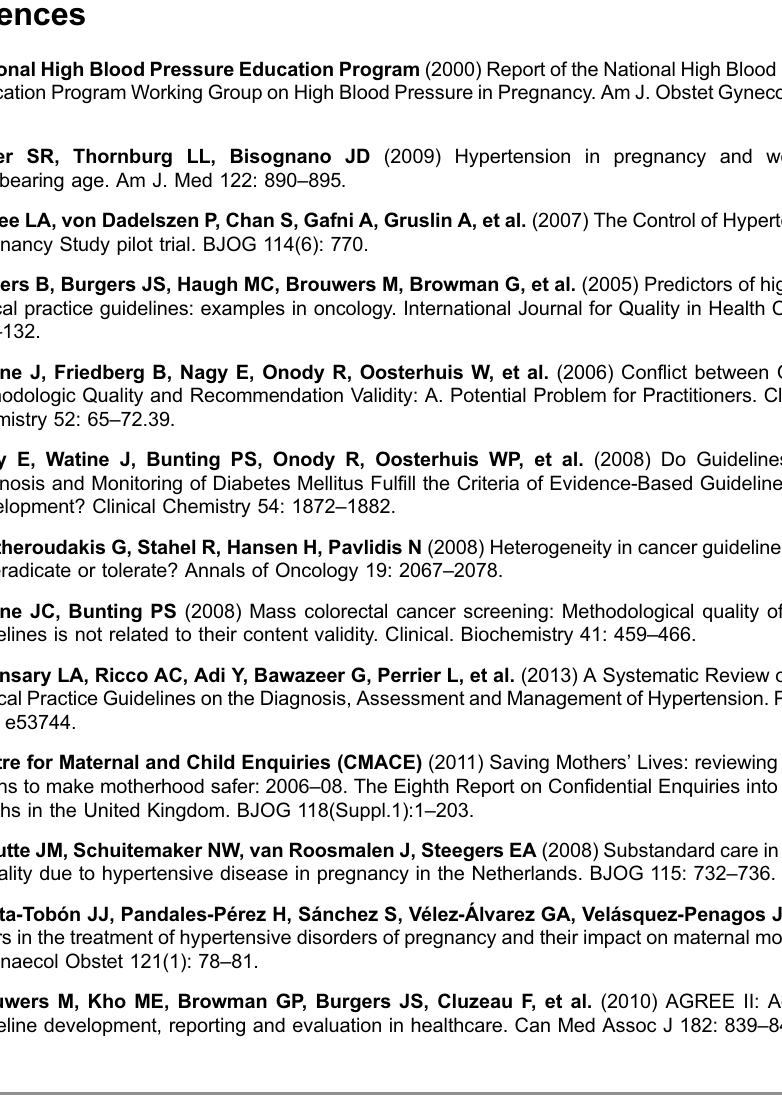
Table S5. Recommendations concerning the Treatment of